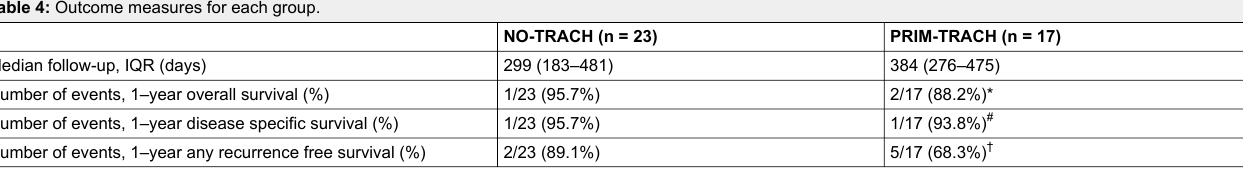
Table 4: Outcome measures for each